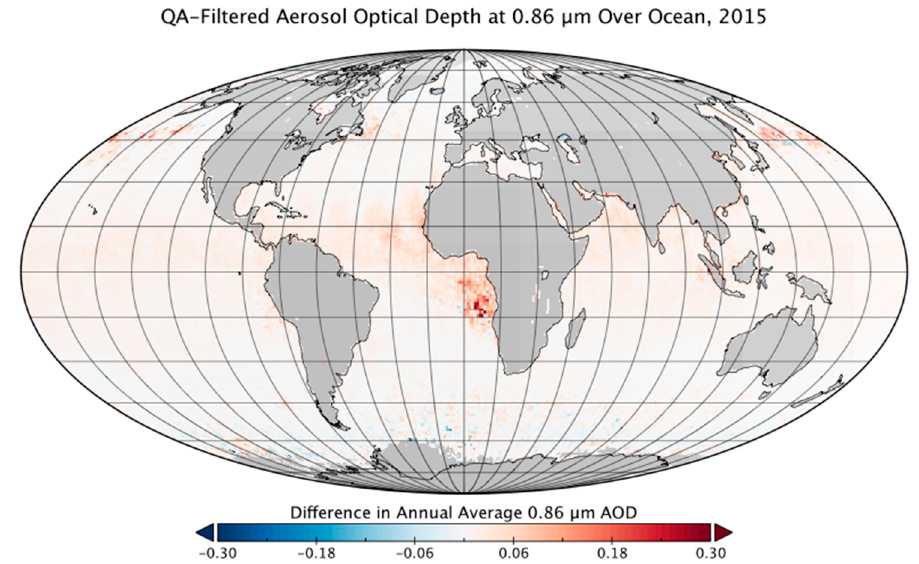
Figure 15. Annual average difference between VIIRS SNPP and MODIS Aqua for QA-filtered AOD at 0.86 μ m over ocean, on a one-degree grid for 2015. The global mean difference is +0.01. However, wavelength-dependent calibration differences are magnified when a derived measurement combines multiple wavelengths. The Ångström exponent over ocean, which is derived from the ratio between the AOD values at 0.55 μ m and 0.86 μ m, has the same regional features in its annual average for both VIIRS SNPP and MODIS Aqua (Figure 16). However, as a percentage of the total, there is a greater disagreement between VIIRS and MODIS in the Ångström exponent, at up to 30%, than there is in AOD at either wavelength, at 15%–20% (Figure 17). On the global average, the positive VIIRS–MODIS offset outweighs the significant negative offsets in cloudier regions, creating an overall positive bias in the VIIRS Ångström exponent. Users of the VIIRS Dark Target Ångström exponent must keep in mind the greater disagreement with MODIS and the regional distribution of positive and negative offsets.